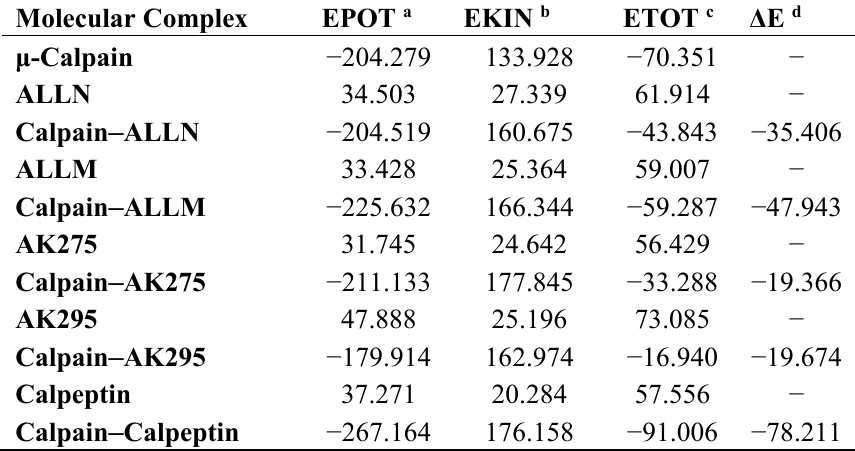
Table 2. Energy attributes calculated for the simulated ligand–protein system in a molecular dynamics setup performed in vacuum at 298